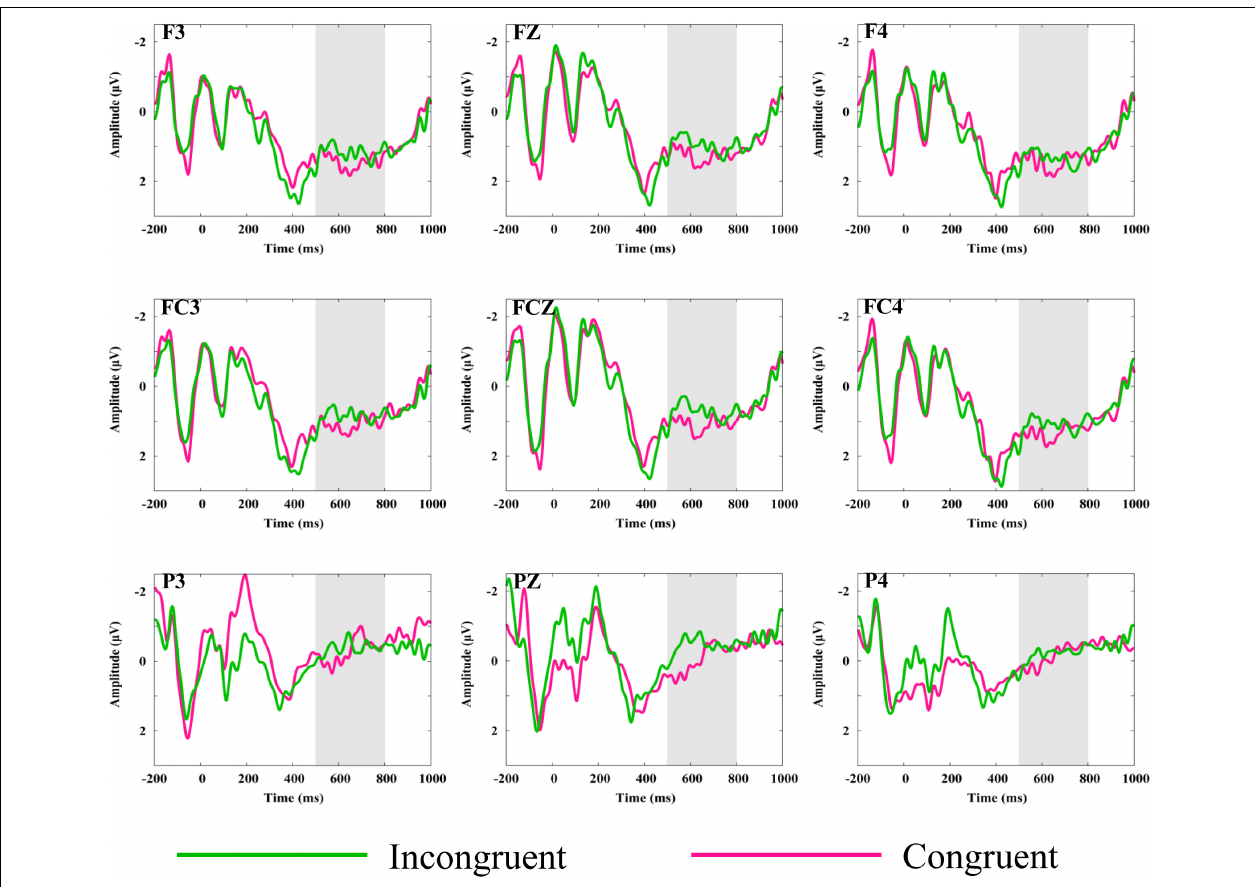
FIGURE 6 | Grand mean ERP waveforms of the congruent-minus-incongruent difference waves derived from the values of fifth picture minus the first picture. Gray-shaded areas indicate the time windows used for statistical analysis. F3, FZ, F4, FC3, FCZ, and FC4 showed larger amplitude of LPP for congruent trials than in congruent trials, while P3, PZ, and P4 showed no significant difference between the two